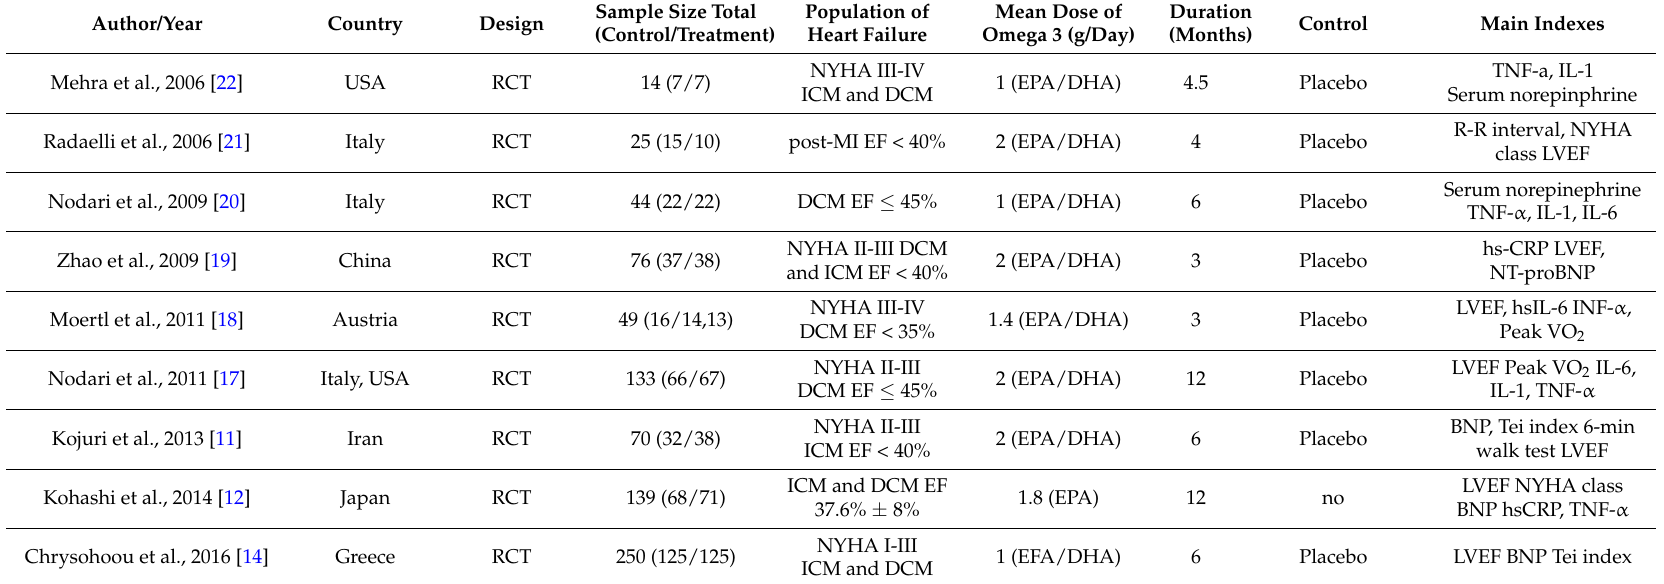
Table 1. Characteristics of included randomised controlled trials